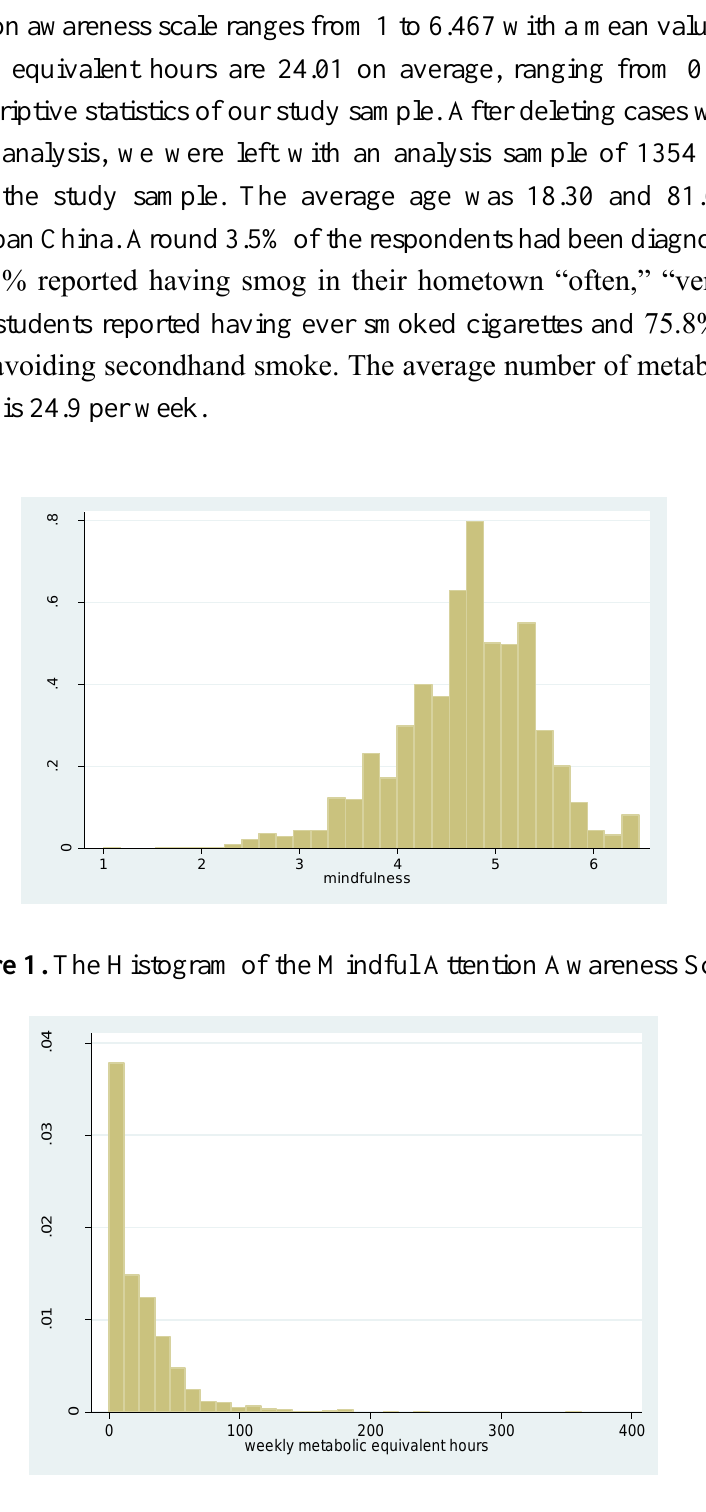
Figure 2. The Histogram of the Weekly Metabolic Equivalent